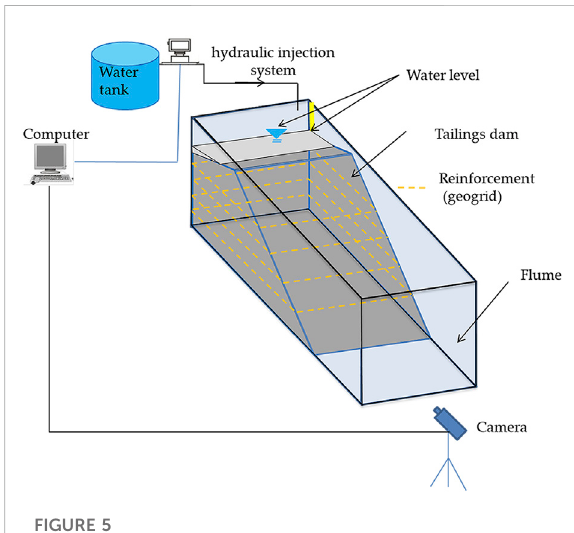
FIGURE 5 Tailing dam overtopping failure test system